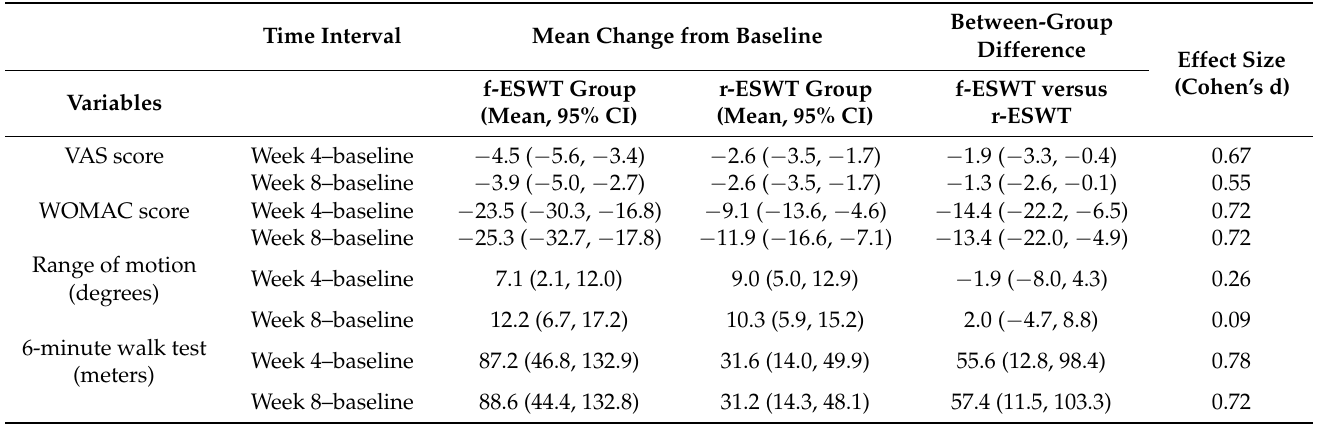
Table 3. Outcome changes from baseline to each follow-up assessment for both